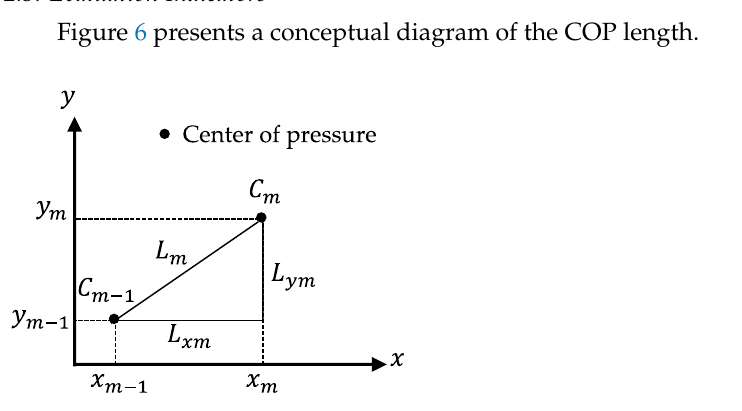
Figure 5. Simulated wave images: ( a ) Pattern 1 (images without waves); ( b ) Pattern 2 (wave direction: 180°); ( c ) Pattern 3 (wave direction: 135°); ( d ) Pattern 4 (wave direction: 90°). Table 4. Motion of the simulated high-speed boat.